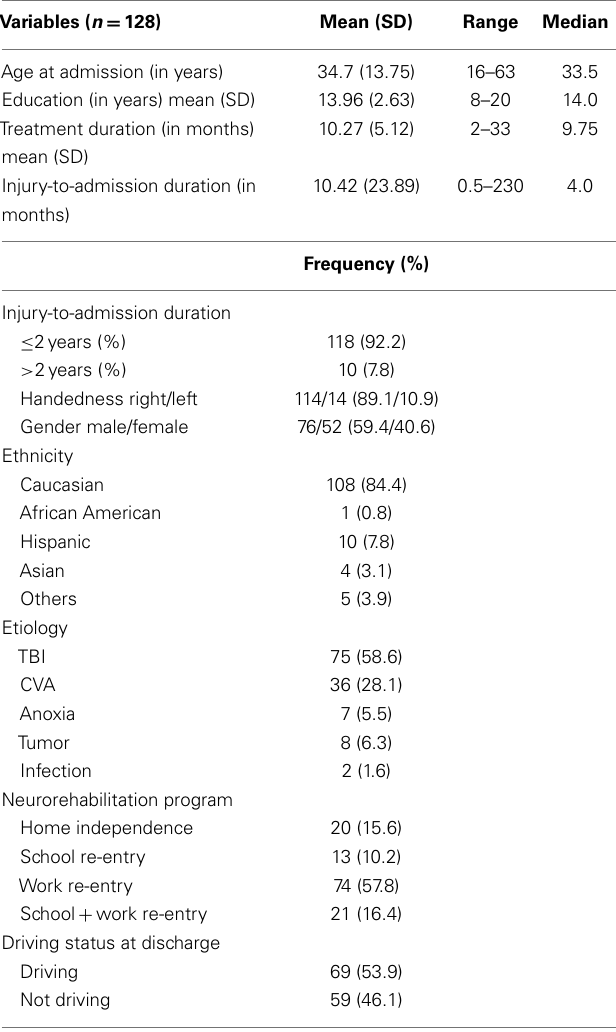
Table 1 | Demographic and clinical